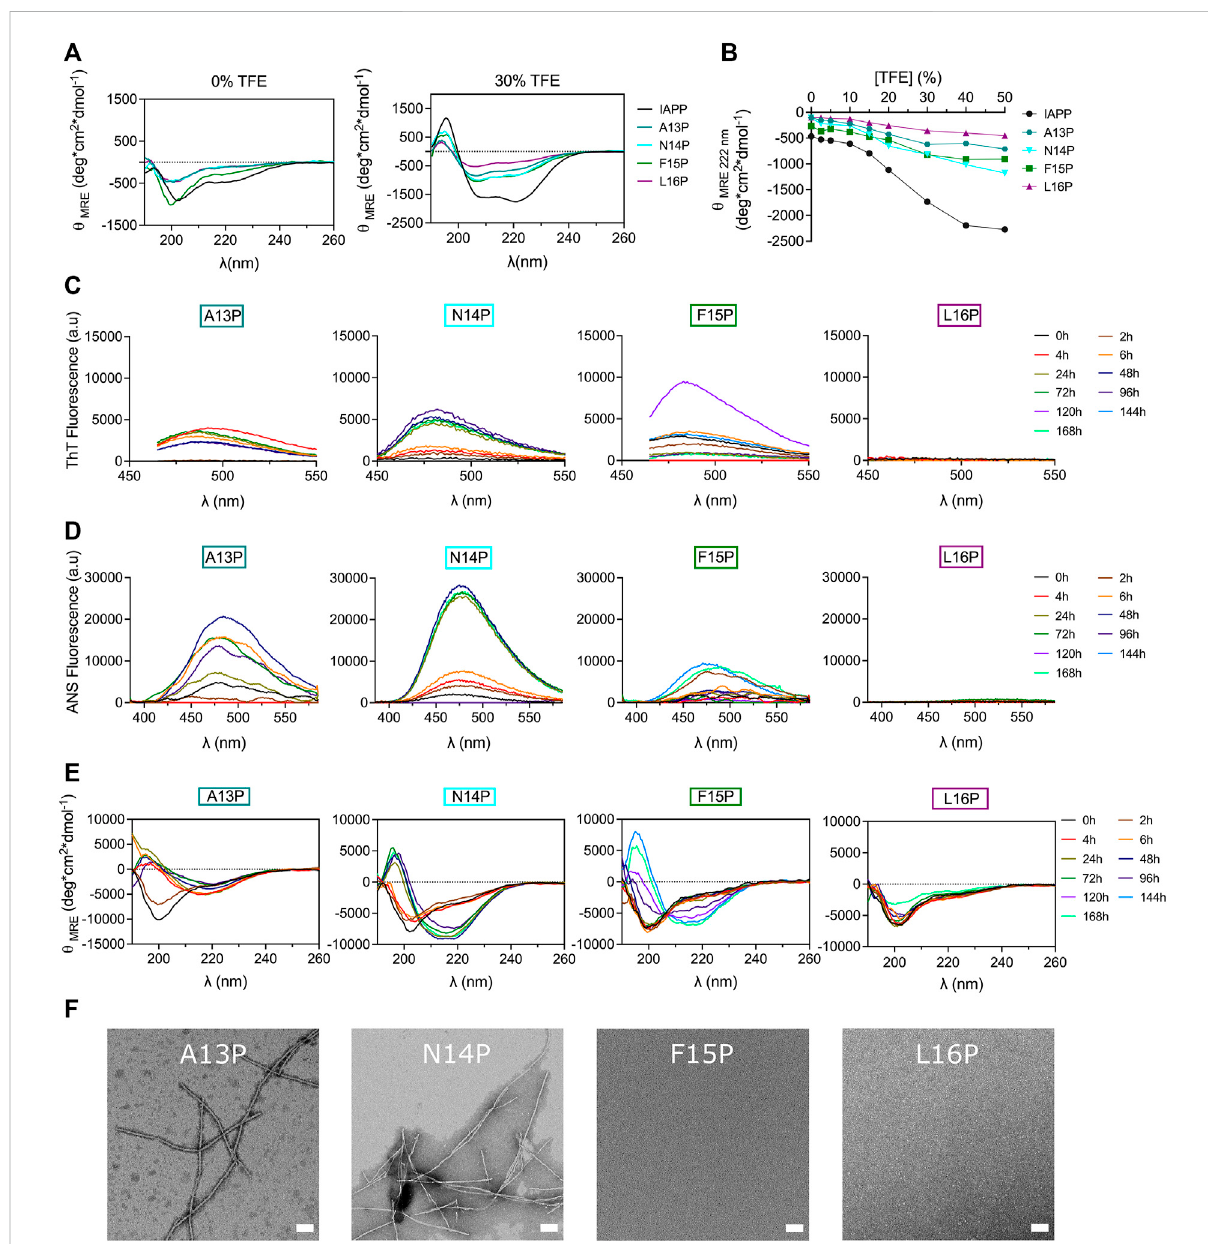
FIGURE 6 EffectsofProsubstitutiononIAPPamyloidself-assembly. (A) Far-UVCDspectraofpeptidesinTris-HCl20 mMinpresence,orabsence,of30% TFE. (B) Effect of TFE on peptide ellipticity measured at 222 nm. (C – E) Peptides were incubated under quiescent conditions in 20 mM Tris-HCl buffer,pH7.4, ataconcentrationof50 μ Mbeforebeingdilutedat25 μ Mfor (C) ThT fl uorescence, (D) ANS fl uorescenceand (E) CDanalysis. (F) TEM images obtained after for 48 h incubation. Scale bar: 100